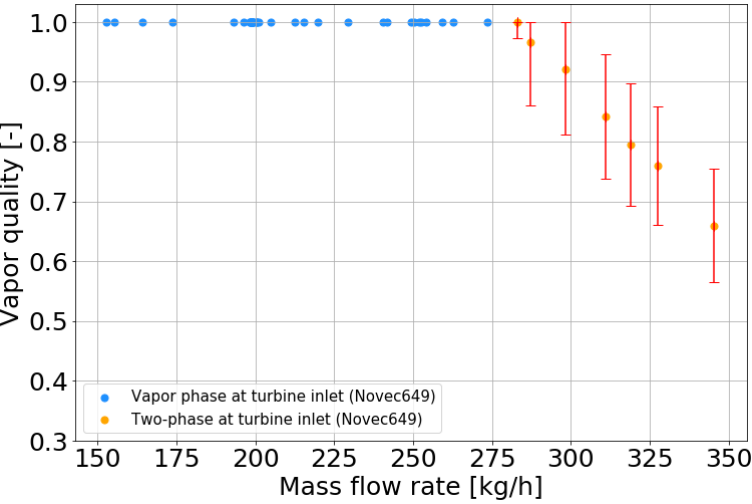
Figure 8. Vapor quality based on the working fluid mass flow rate.